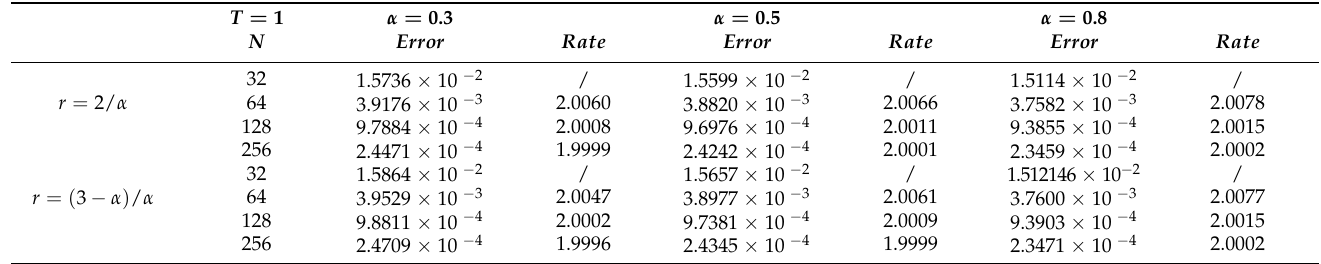
Table 8. Temporal numerical results of (cid:107) I h u n − U n (cid:107) 1 on graded meshes to Example 2.